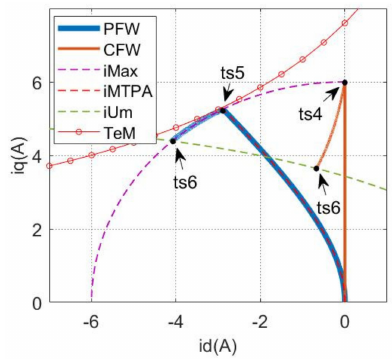
Figure 10. Current trajectories. iMax: maximum current, iMTPA: MTPA trajectory, iUm: current trajectory of f U = 0, and TeM: maximum electrical torque’s